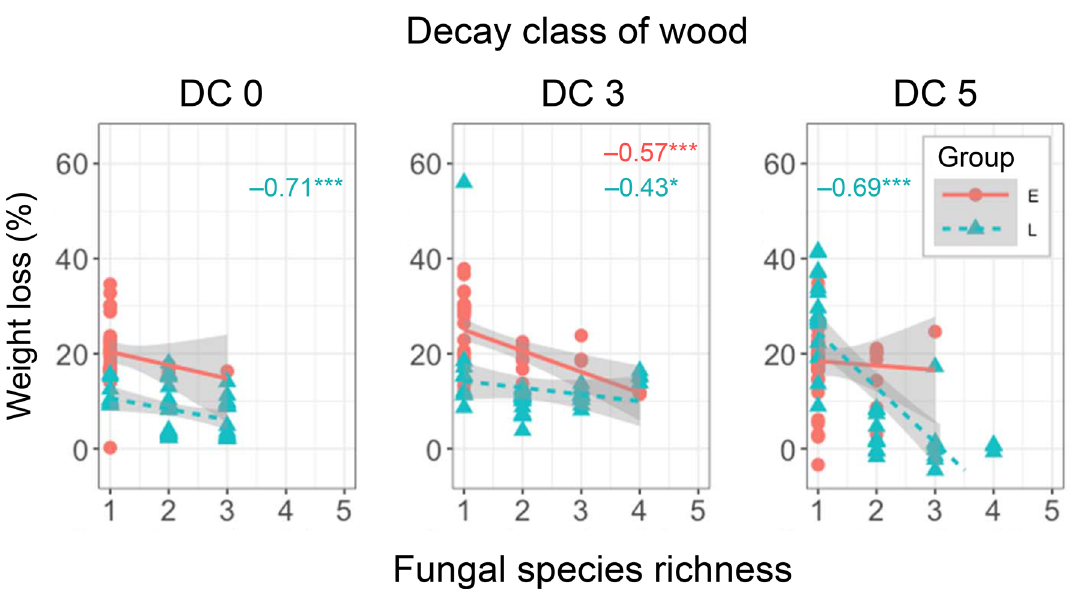
Figure 5. Relationships between fungal species richness (without contaminant OTUs) and wood weight loss (% of control wood). Red round symbols indicate E group, and blue triangles L group. Red and blue numbers with asterisks represent significant Pearson’s correlation coefficients for groups E and L, respectively. Asterisks indicate * P < 0.05 and *** P <